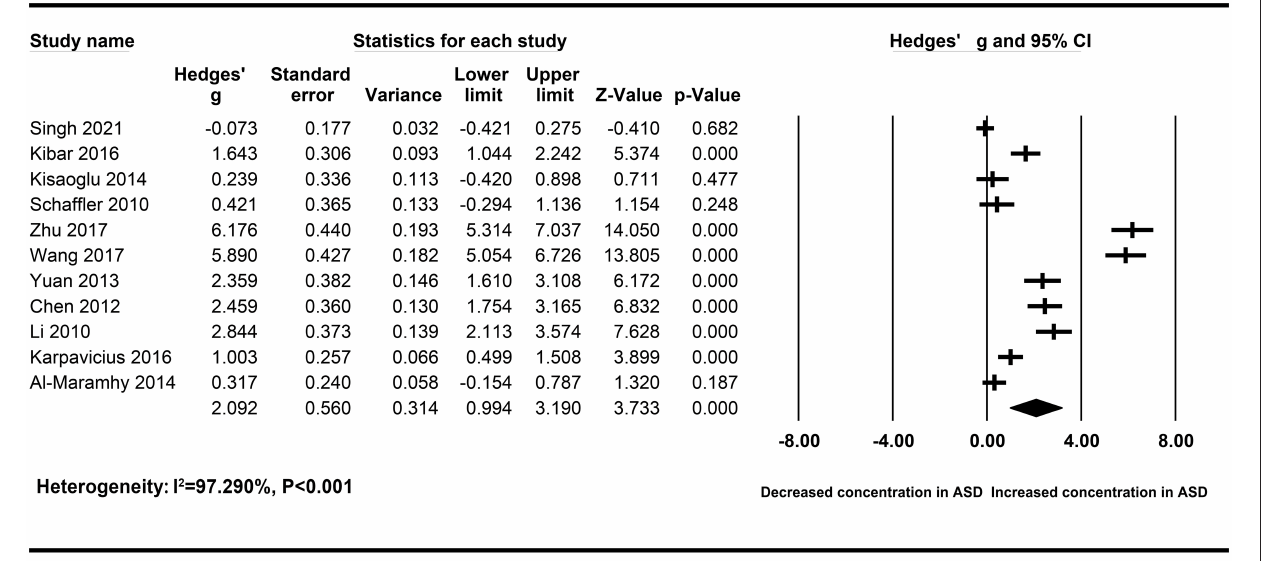
FIGURE 2 | Forest plot for the random-effect meta-analysis.